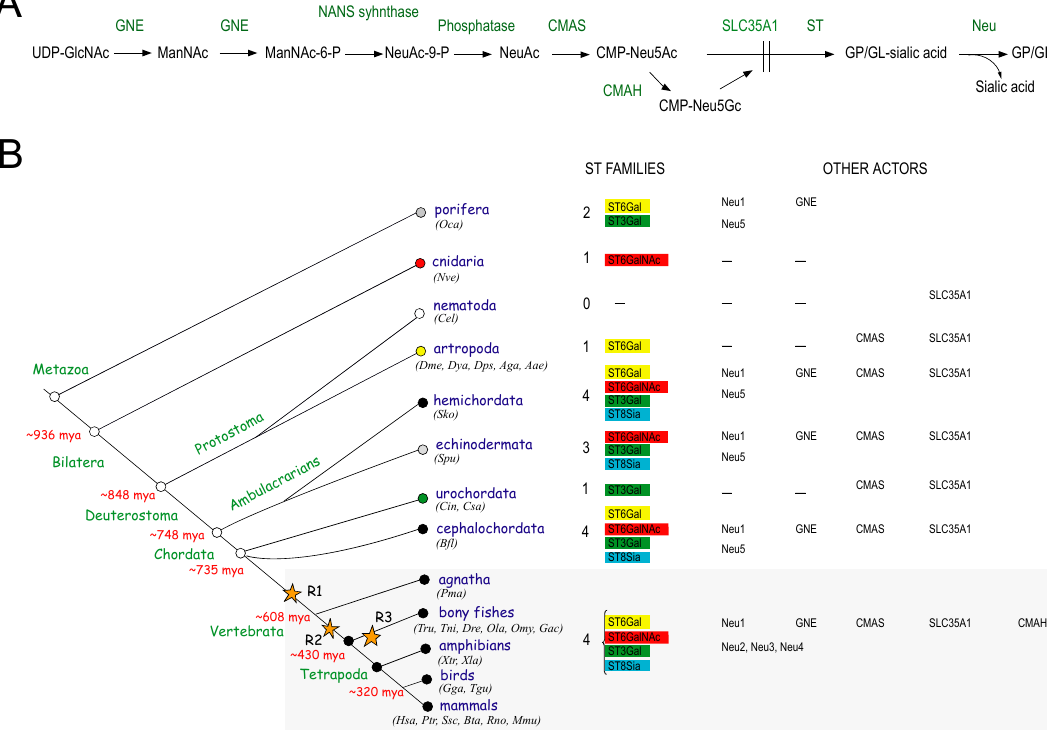
Figure 2. Evolution of the biosynthetic pathway of sialic acids in Metazoa. ( A ) Schematic representation of the vertebrate biosynthetic pathway of sialylated molecules. Key enzymes implicated in the biosynthetic pathway of sialic acids are indicated as follows: GNE: UDP-GlcNAc2epimerase/ManNAc kinase; NANS: Neu5Ac9-phosphate synthase; CMAS: CMP-Neu5Ac synthase: CMAH: CMP-Neu5Ac hydroxylase; SLC35A1: CMP-Neu5Ac transporter; ST: sialyltransferases, Neu: neuraminidase; ( B ) Illustration of the evolutionary history of the sialic acid biosynthetic pathway in the metazoans. Evidences of the occurrence of the biosynthetic pathway of sialylated molecules across the metazoans have been obtained based on BLAST search analysis of the various actors in genomic databases. Yellow stars indicate the two whole genome duplication events (WGD R1–R2) that took place at the base of vertebrates and the teleostean whole genome duplication event (WGD R3) that occurred in the stem of bony fish.